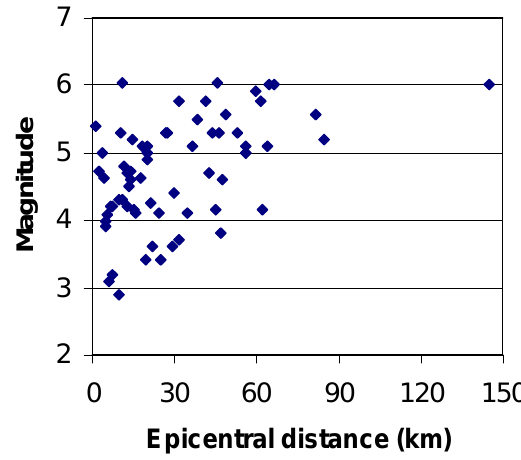
Fig. 3. Magnitude vs. epicentral distance for training Figure 3. Magnitude vs epicentral distance for training set